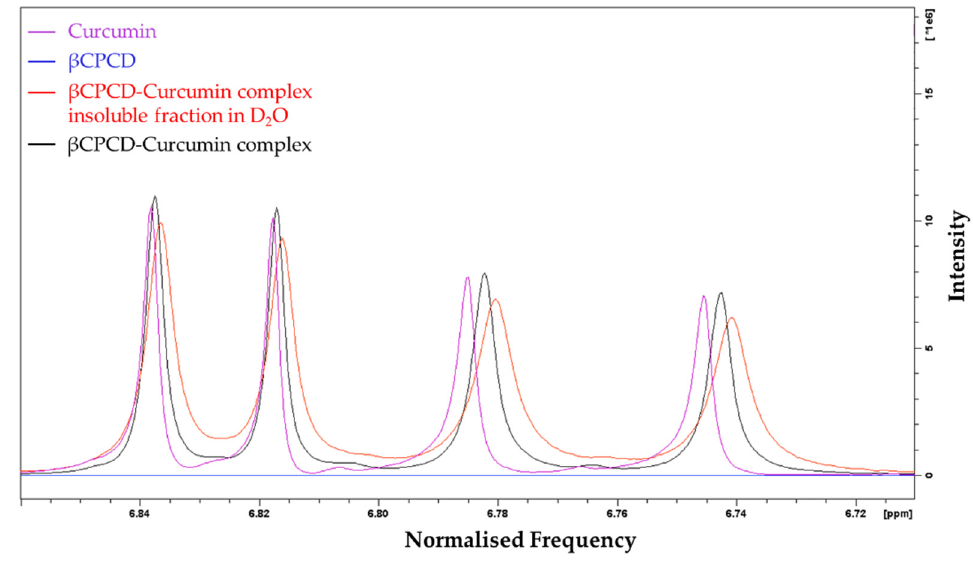
Figure 6. Comparison of 1 H NMR spectra, in DMSO-d 6 of curcumin (purple), β CPCD (blue), insoluble fraction in D 2 O of β CPCD–curcumin mixture (red) and β CPCD–curcumin mixture (black) at 6.86–6.71 ppm .